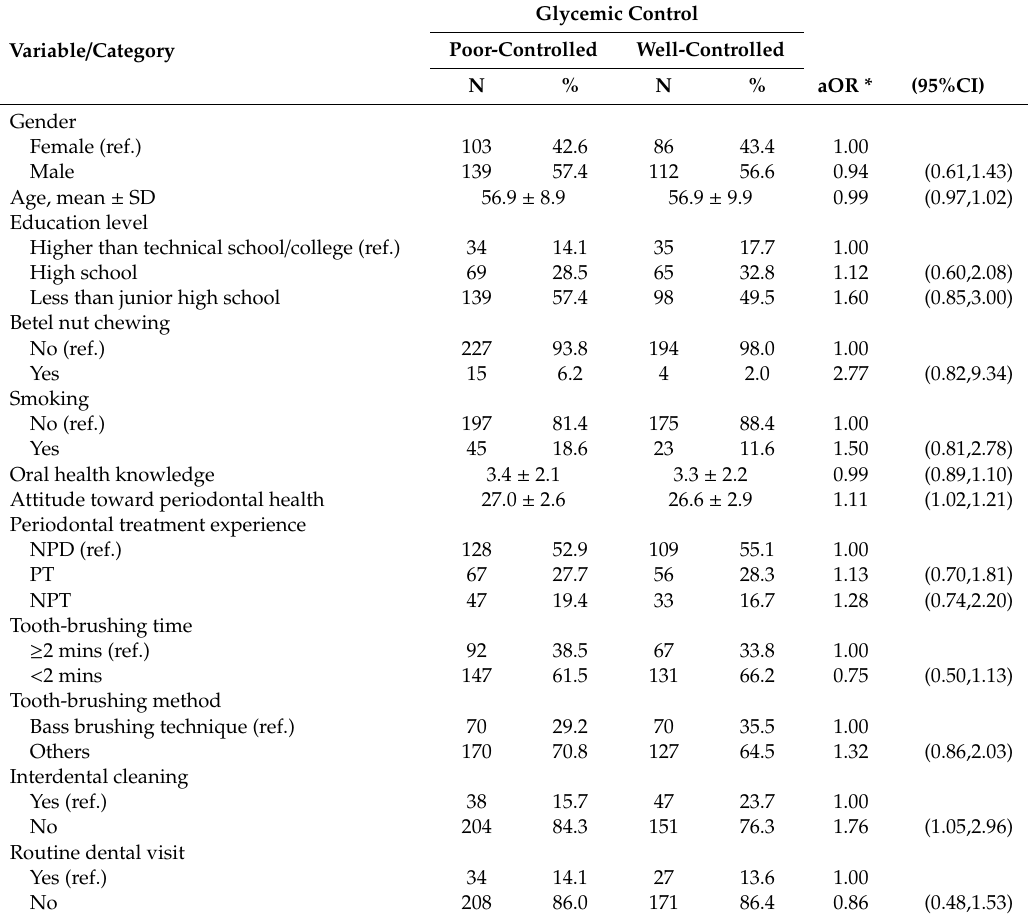
Table 2. The adjusted odds ratio (aOR) for glycemic control status associated with selected variables in T2DM